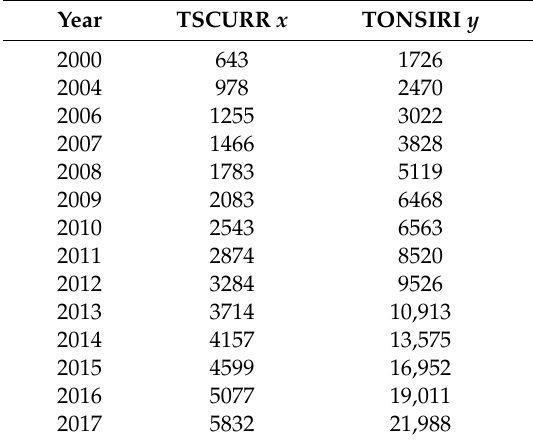
Table 1. The primary quality parameters data (unit: RMB 100 million). Year TSCURR x TONSIRI y 2000 643